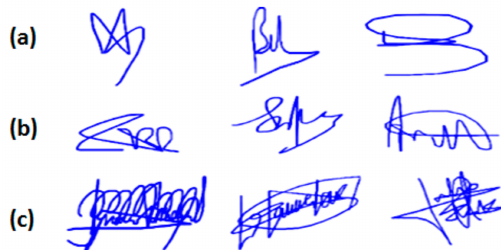
Figure 7. Examples of signatures captured in uncontrolled mobile conditions with ( a ) high, ( b ) medium and ( c ) low